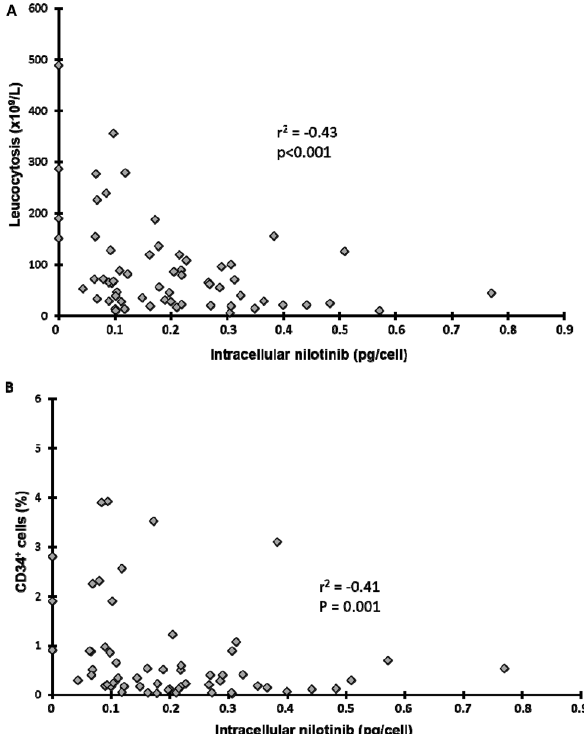
Figure 5. Relationship between intracellular nilotinib in PMN cells and tumour burden in the whole population. Relationship between nilotinib concentration in mature PMN cells and ( A ) leucocytosis and ( B ) percentage of CD34 + cells in peripheral blood (n = 61